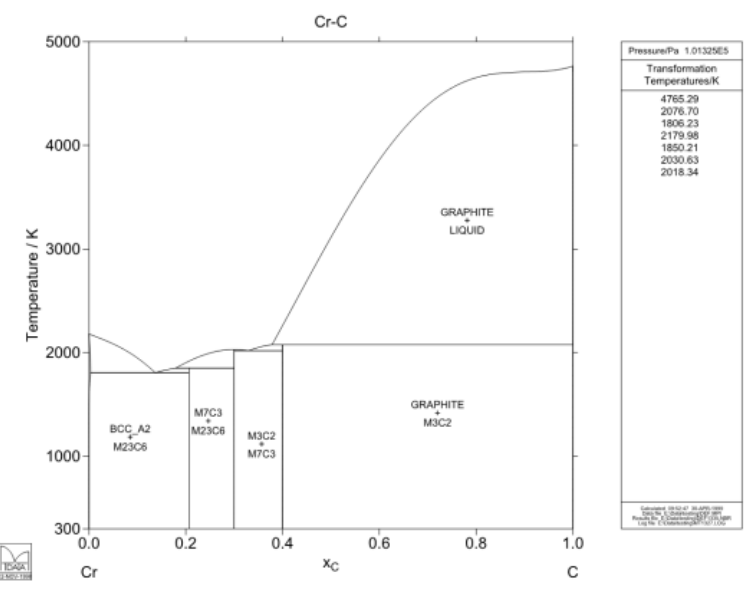
Figure 11. Cr-C phase diagram.